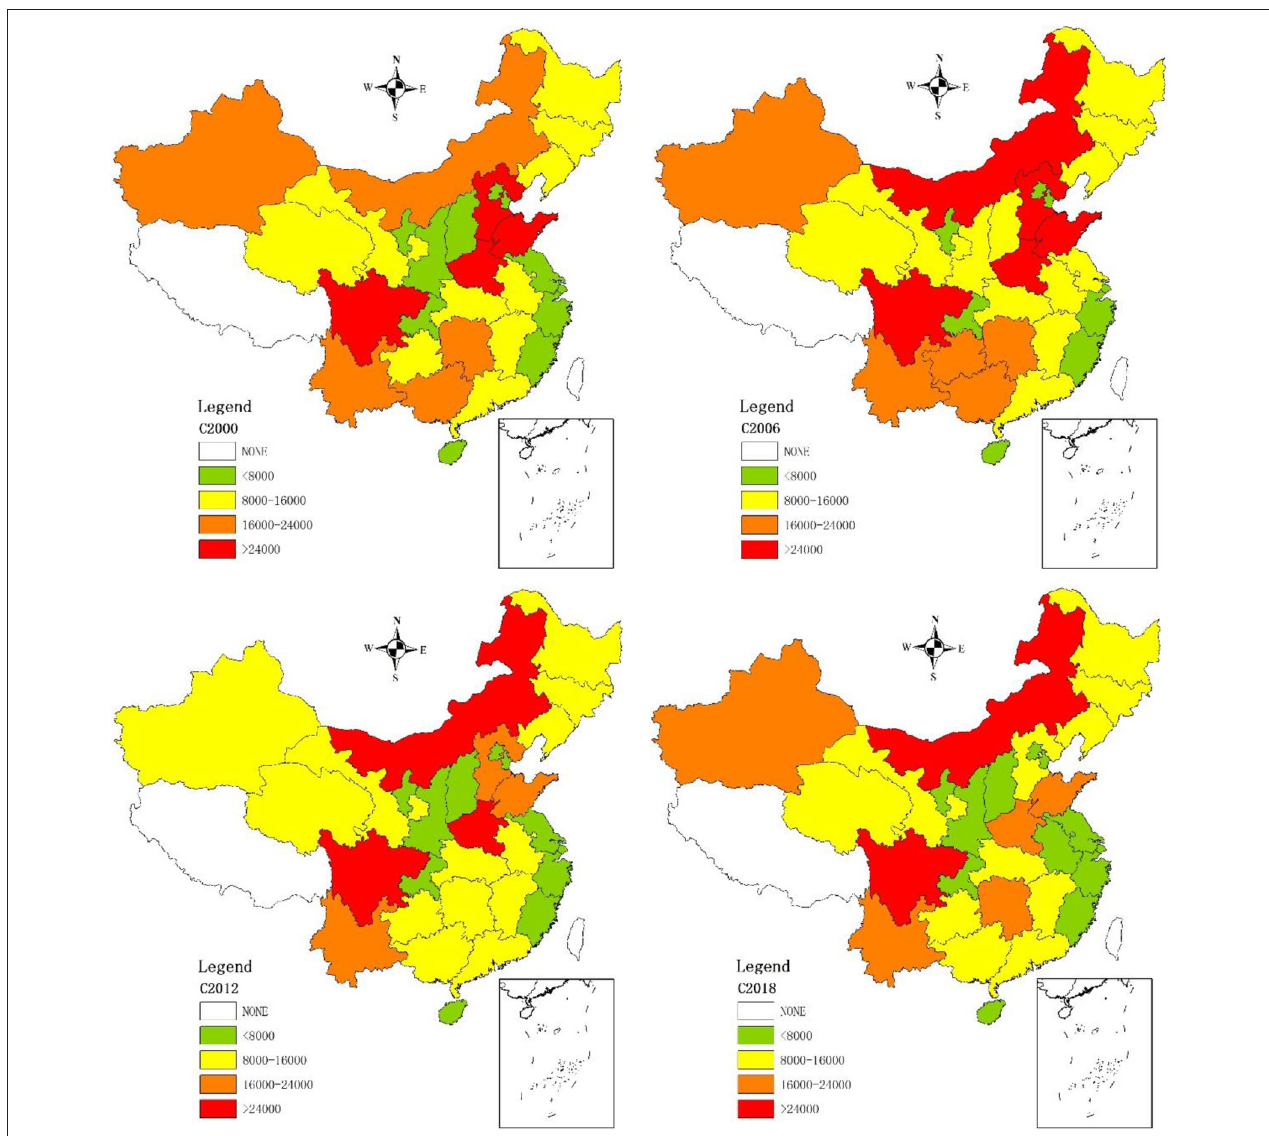
FIGURE 3 | Change and distribution of carbon emissions of animal